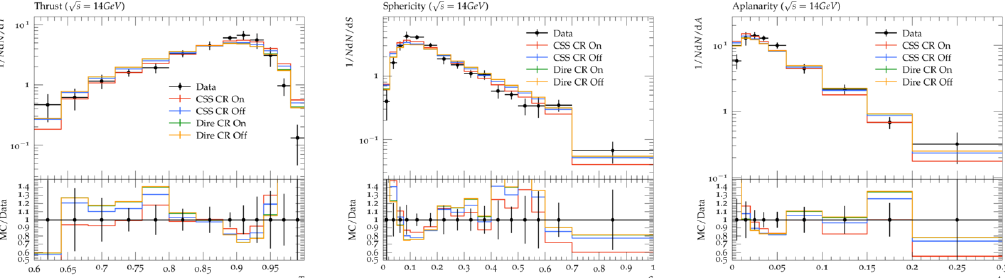
Figure 13: Various event shapes – from left: thrust, sphericity, and aplanarity mea- sured by T ASSO [ 70 ] .